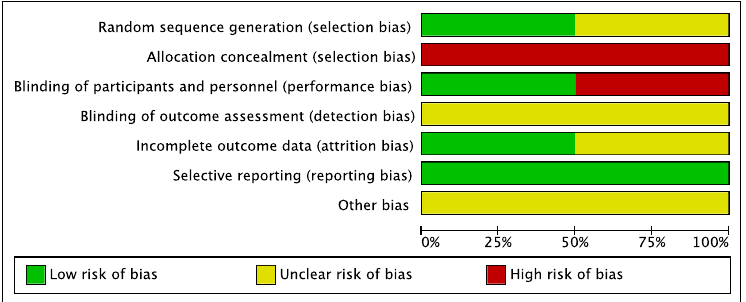
Figure 3. Risk of bias graph across randomised controlled trials. Low risk of bias: green; Unclear risk of bias: yellow; High risk of bias: red.